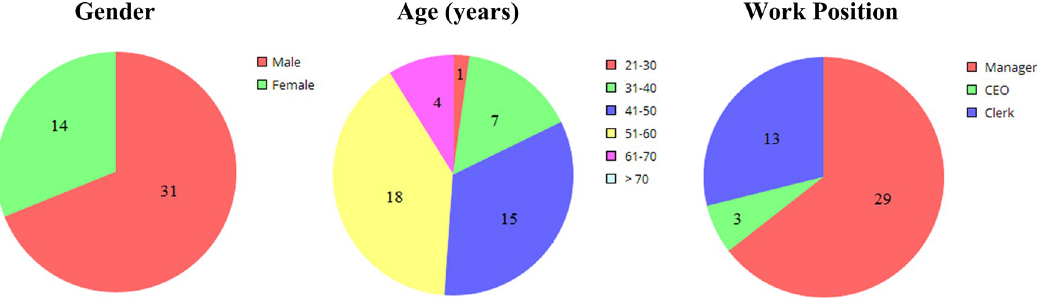
Fig 3. Details regarding the